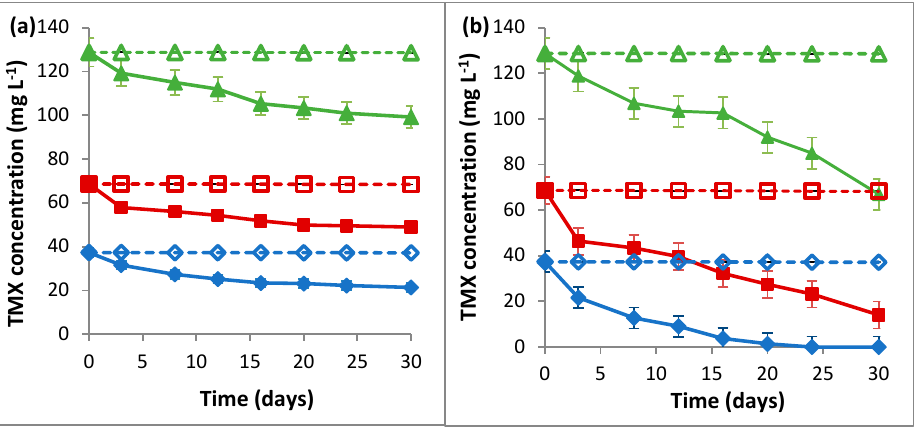
) and adsorption (cid:35)